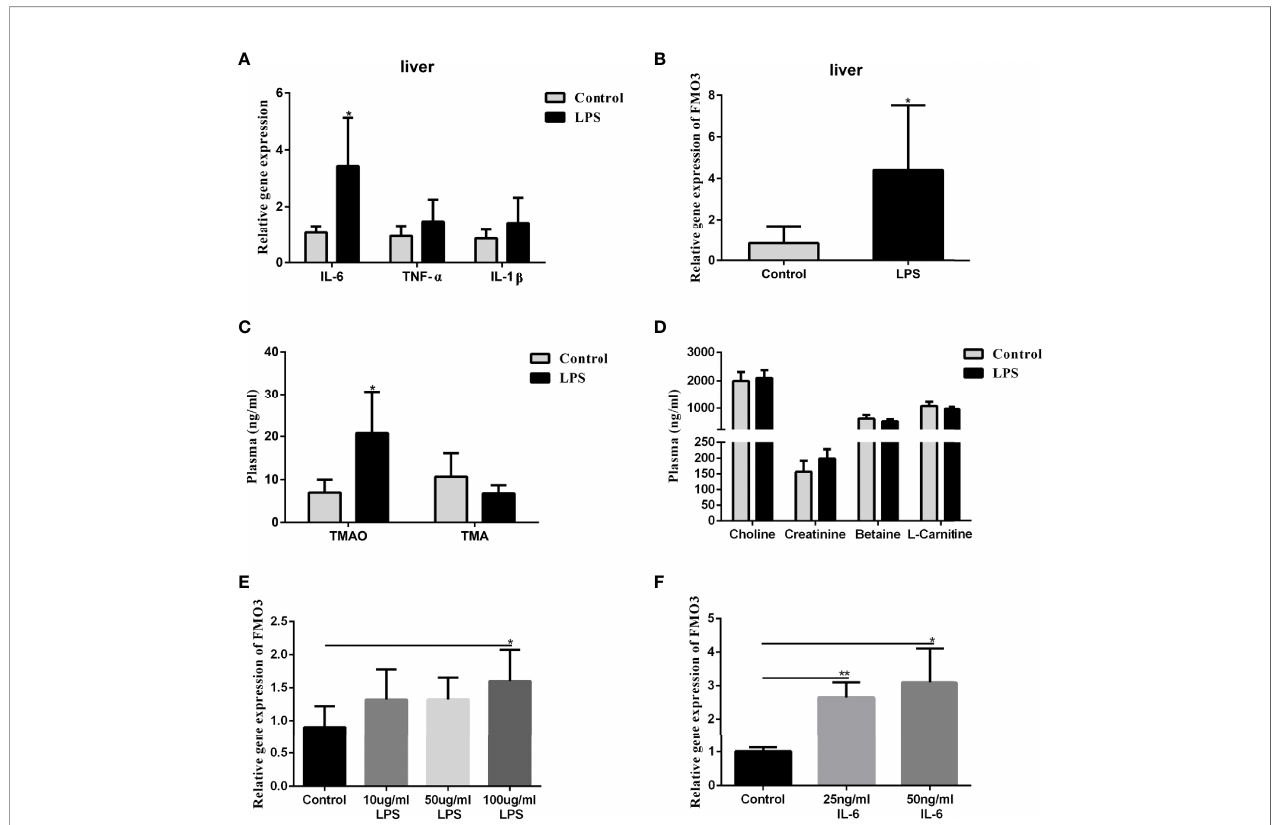
FIGURE 4 | Effect of LPS on plasma TMAO/TMA levels, plasma Choline/Creatinine/Betaine/L-Carnitine levels, and the expression of FMO3 and in fl ammatory factors in the liver. Effect of LPS and IL-6 stimulation on FMO3 expression in HepG2 cell. (A) Relative gene expression levels of in fl ammatory cytokines in the liver tissue. (B) Relative gene expression levels of FMO3 in the liver tissue. (C) TMAO and TMA levels in plasma. (D) Choline, Creatinine, Betaine, and L-Carnitine levels in plasma. (E) comparisons of relative gene expression levels of FMO3 in the 10, 50, and 100 m g/ml LPS-treatment HepG2 cell. (F) relative gene expression levels of FMO3 in the 25, 50 ng/ml IL-6-treatment HepG2 cell. Data are presented as mean ± SEM. (n = 5/group). *P <0.05; P <